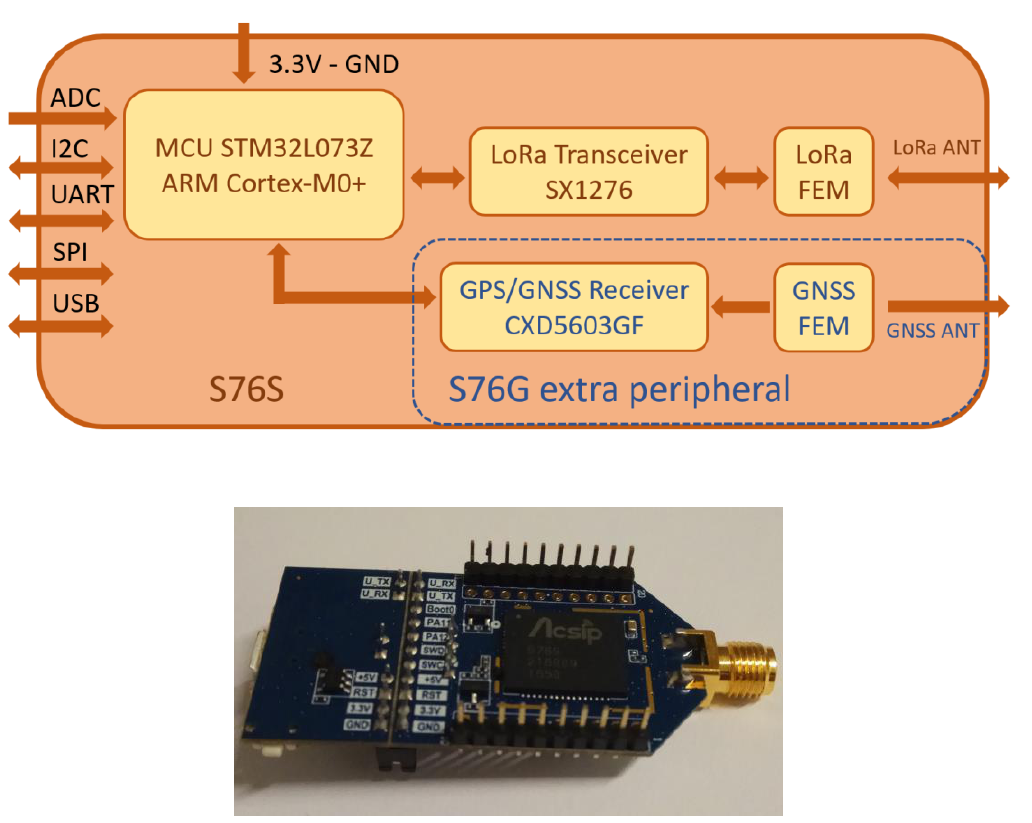
Figure 1. The simplified block diagram of the S76G chip, produced by Acsip, and the evaluation board of the S76G chip.